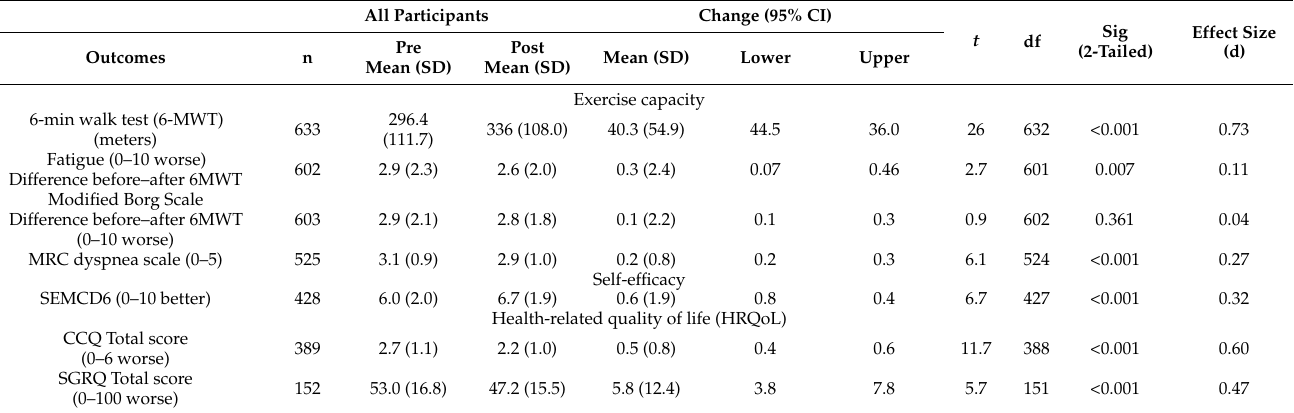
Table 2. Change in outcomes for pre–post participation in the pulmonary rehabilitation program and effect